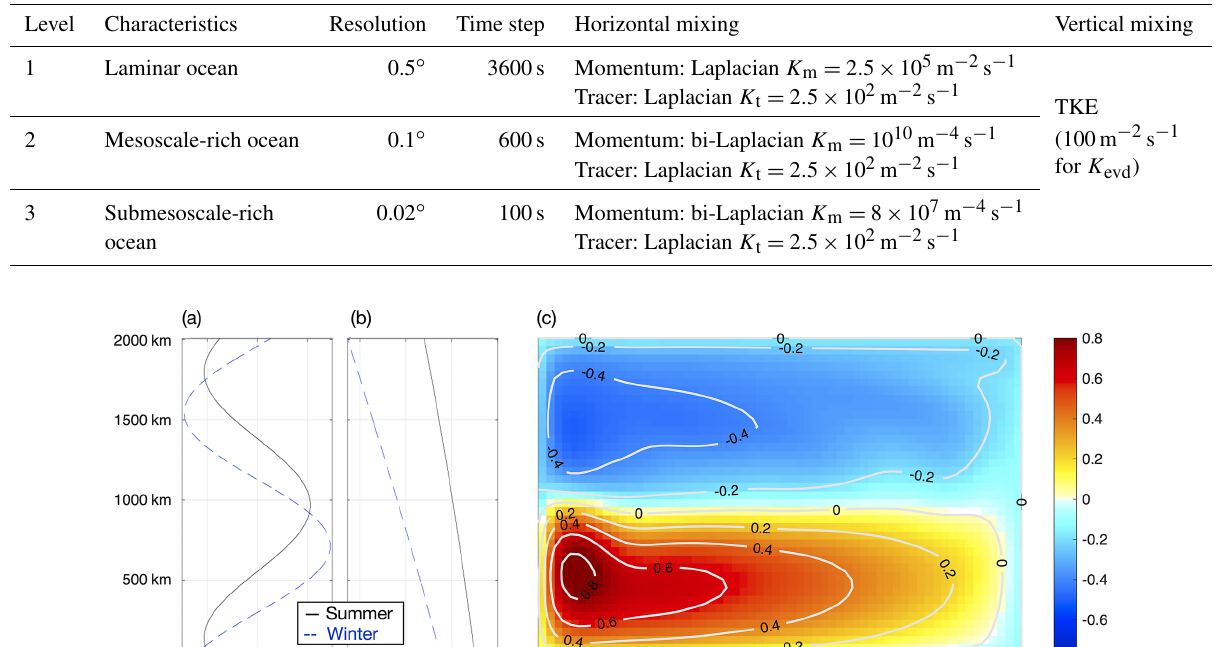
tion is interconnected and has irregular boundaries, covering the western boundary, the majority of the northern and south- ern boundary, WBC, and the extension of the WBC. In addi- tion, in the subpolar gyre, the refined region to 0.1 ◦ in L-M-I covers more area than that in L-M-II. Conversely, in the sub- tropical gyre, the refined region is smaller in L-M-I than that in L-M-II. The area of the region refined to 0.1 ◦ is 56 % and 61 % of the whole basin for L-M-I and L-M-II, respectively. Compared with 0.5 ◦ resolution, the experiment with 0.1 ◦ resolution shows much higher overall kinetic energy (Fig. 7). At equilibrium, the annual mean surface KE is about 0.035 m − 2 s − 2 for 0.1 ◦ , which is about 2.5 times that at 0.5 ◦ . This corresponds to the mesoscale turbulence, which man- ifests at the spatial resolution of 0.1 ◦ (10 km) or finer. For comparison, at 0.5 ◦ , the model only simulates laminar flow, despite the presence of WBC (Fig. 5b and video supplement). Also the distinct seasonal cycle of surface KE at 0.1 ◦ is both larger in magnitude (0.01 m − 2 s − 2 v.s. 0.005 m − 2 s − 2 ) and different in terms of the month with maximum KE (May